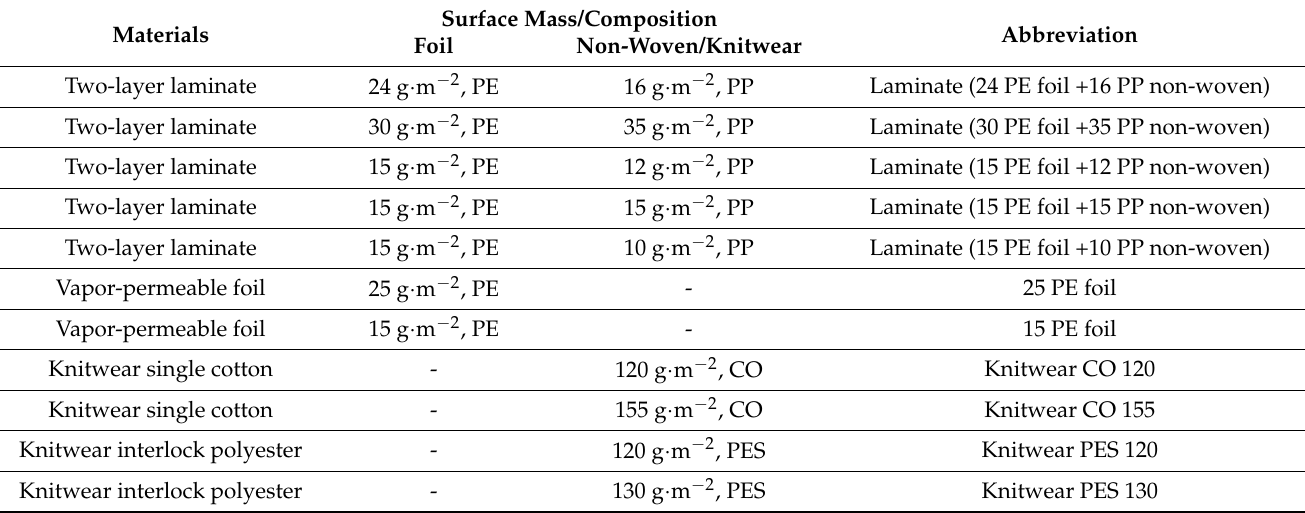
Table 1. Characterization of the